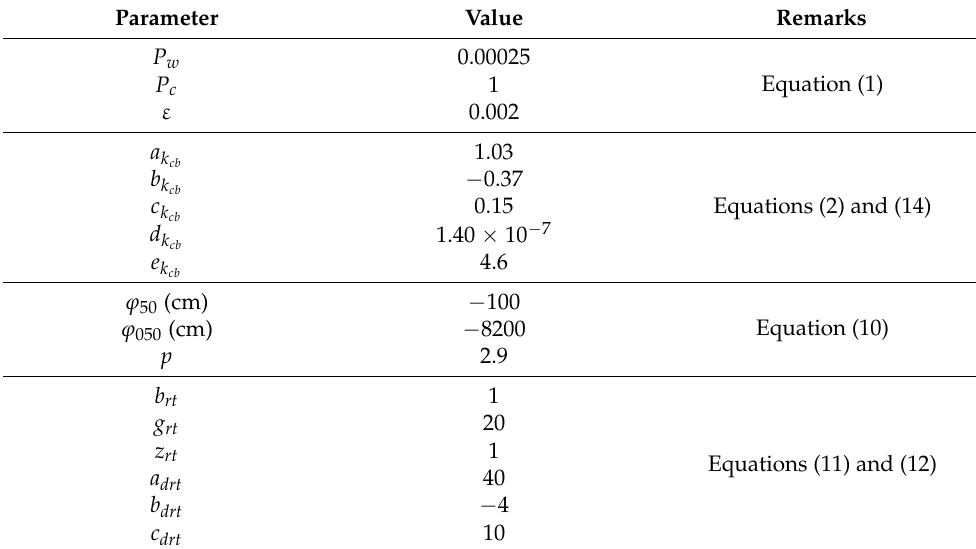
Table 2. Parameter values for plant stress response and growth properties used in the numerical modeling in this study.